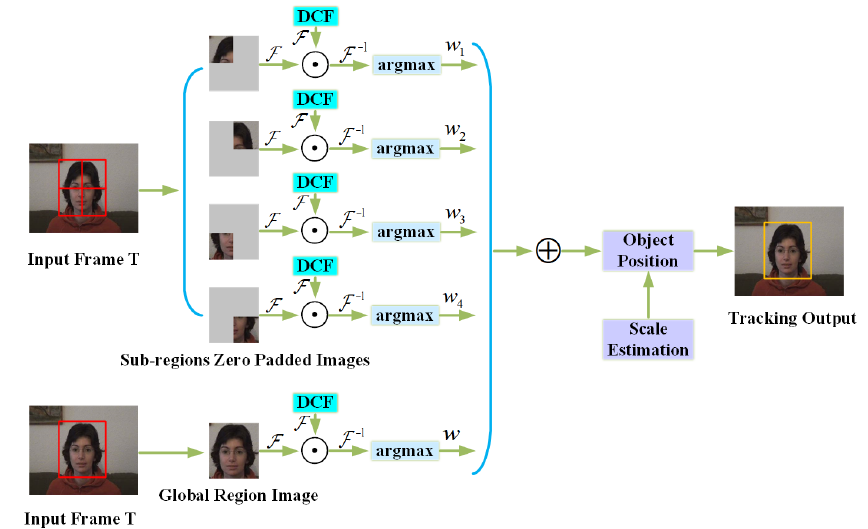
Figure 1. Overview of our algorithm. In the t -th frame, the sliding window obtains the sub-region and global region images, and the sub-region images are zero-padded to the same size as the global image. Subsequently, the correlation operation is performed with the trained DCFB in the frequency domain, and the position corresponding to the maximum correlation response is weighted to make the joint optimization the final target position. In addition, accurate scale estimation makes the tracking process more